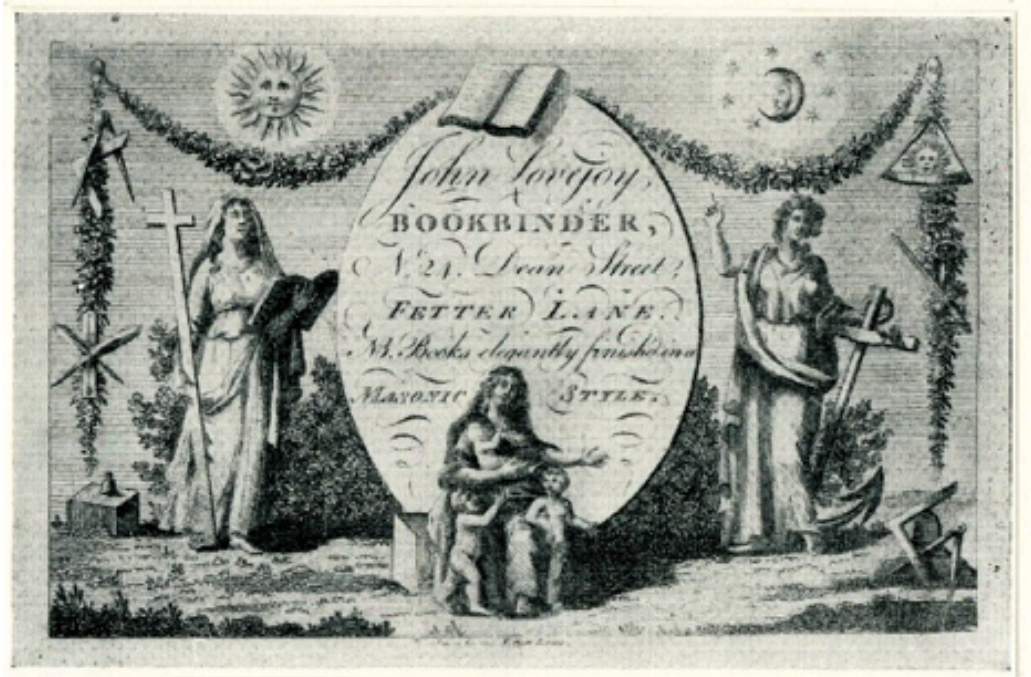
Fig. 4. John Lovejoy’s trade card. Copyright, The Trustees of the British Museum. Heal,